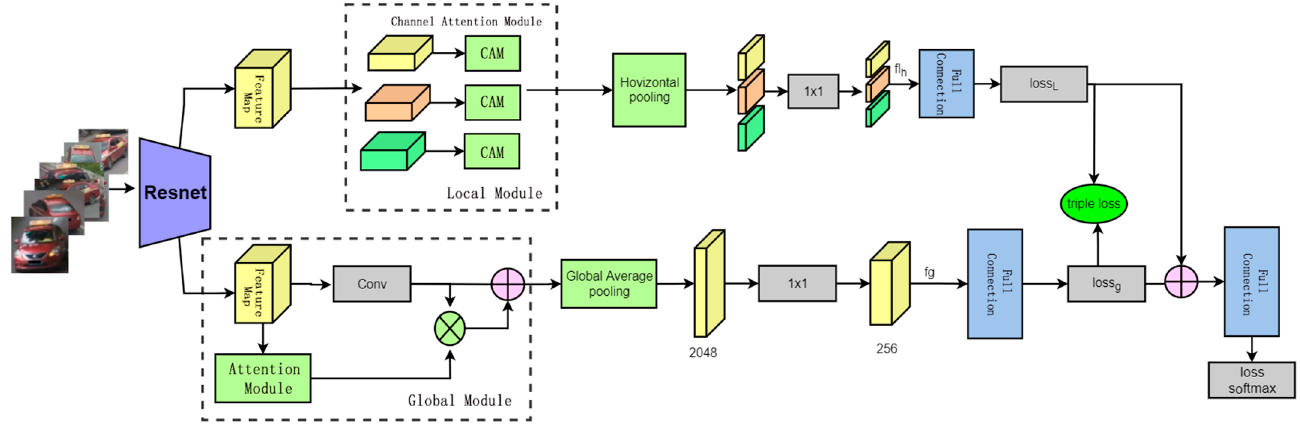
Figure 1. Re-ID network framework based on a tt ention module.